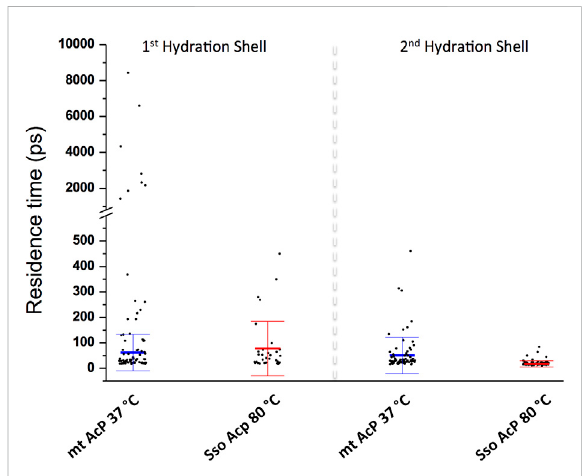
Dynamic properties of waters inthe MDHS ofmt AcP and Sso AcP. Water residence time in each MDHS was calculated using the autocorrelation function and a single exponential decay fi tting model. The MDHS were classi fi ed as those belonging to the fi rst or second hydration shell. Scatter plots of the residence times are reported for the two classes of MDHS for mt AcP at 37 ° C and Sso AcP at 80 ° C. In the fi rst hydration shell, the average residence times were calculated by excluding superstructured MDHS (residence times higher than 1.0 ns), resulting in 62.5 (±72.2) ps and 78.5 (±99.7) ps for mt AcP at 37 ° C and Sso AcP at 80 ° C, respectively. In the second hydration shell, average residence times were 51.6 (±72.2) ps and 17.9 (±12.1) ps for mt AcP at 37 ° C and Sso AcP at 80 °